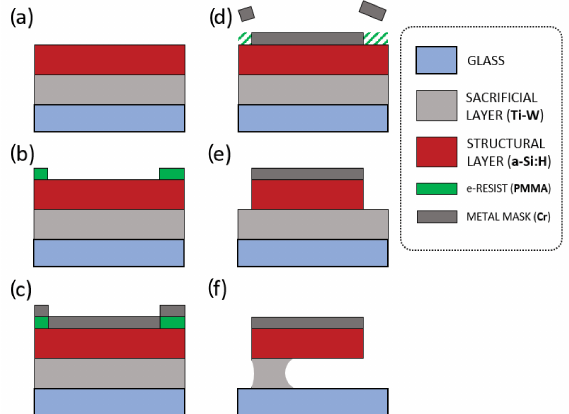
Figure 9. Fabrication process flow. ( a ) Materials deposition: sputtering of the sacrificial layer and Plasma Enhanced Chemical Vapor Deposition (PECVD) of the structural layer. ( b ) EBL: definition of the inverse image with respect to the device’s pattern using PMMA electron-beam resist. ( c ) Vacuum Evaporation of chromium (metal mask). ( d ) Lift-off: definition of the device’s final pattern. ( e ) Structure patterning via RIE. ( f ) Structure releasing via wet etching of the sacrificial